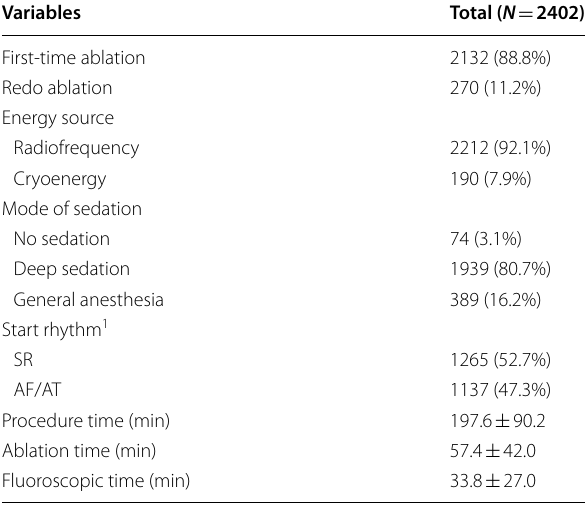
Table 2 Baseline procedural characteristics of the study